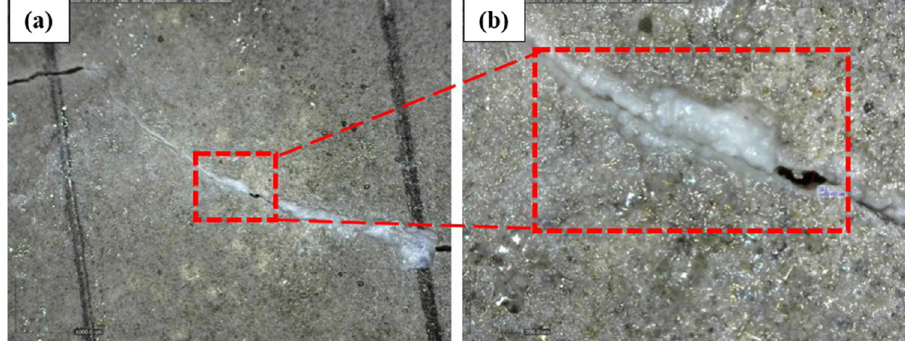
Figure 14: Image taken from crack fi lled with precipitation of calcium carbonate at the magni fi cations of ( a ) 50 × and ( b ) 230 × [ 13 ]